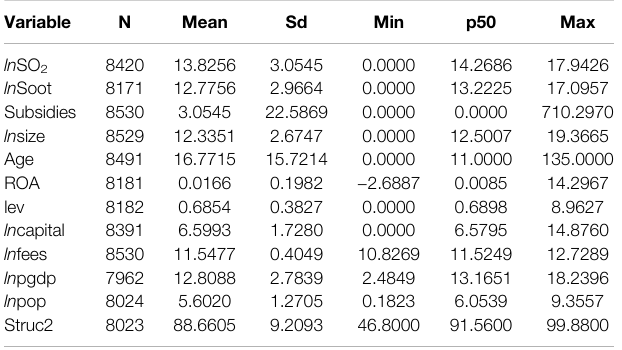
TABLE 3 | Robustness test results of substitution